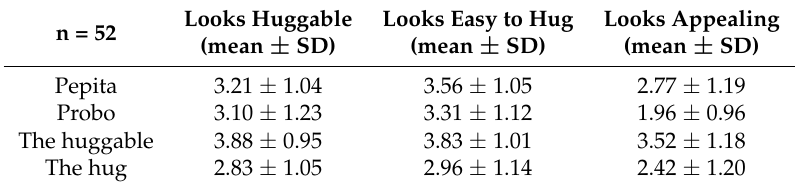
Table 1. Results of the comparison among huggable robots based on their appearance. (SD: stantard